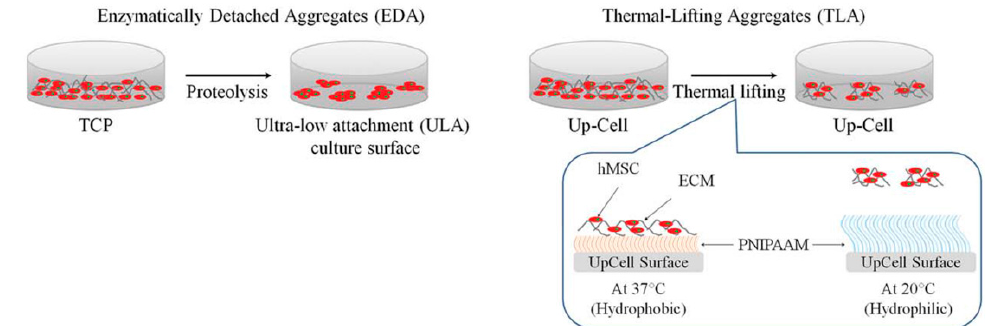
Figure 5. Schematics of human mesenchymal stem cells (hMSC) aggregate formation based on hydrogel. TCP: tissue culture plastics, PNIPAAM: poly-N-isopropyl acrylamide. (Reproduced from Reference [55]).